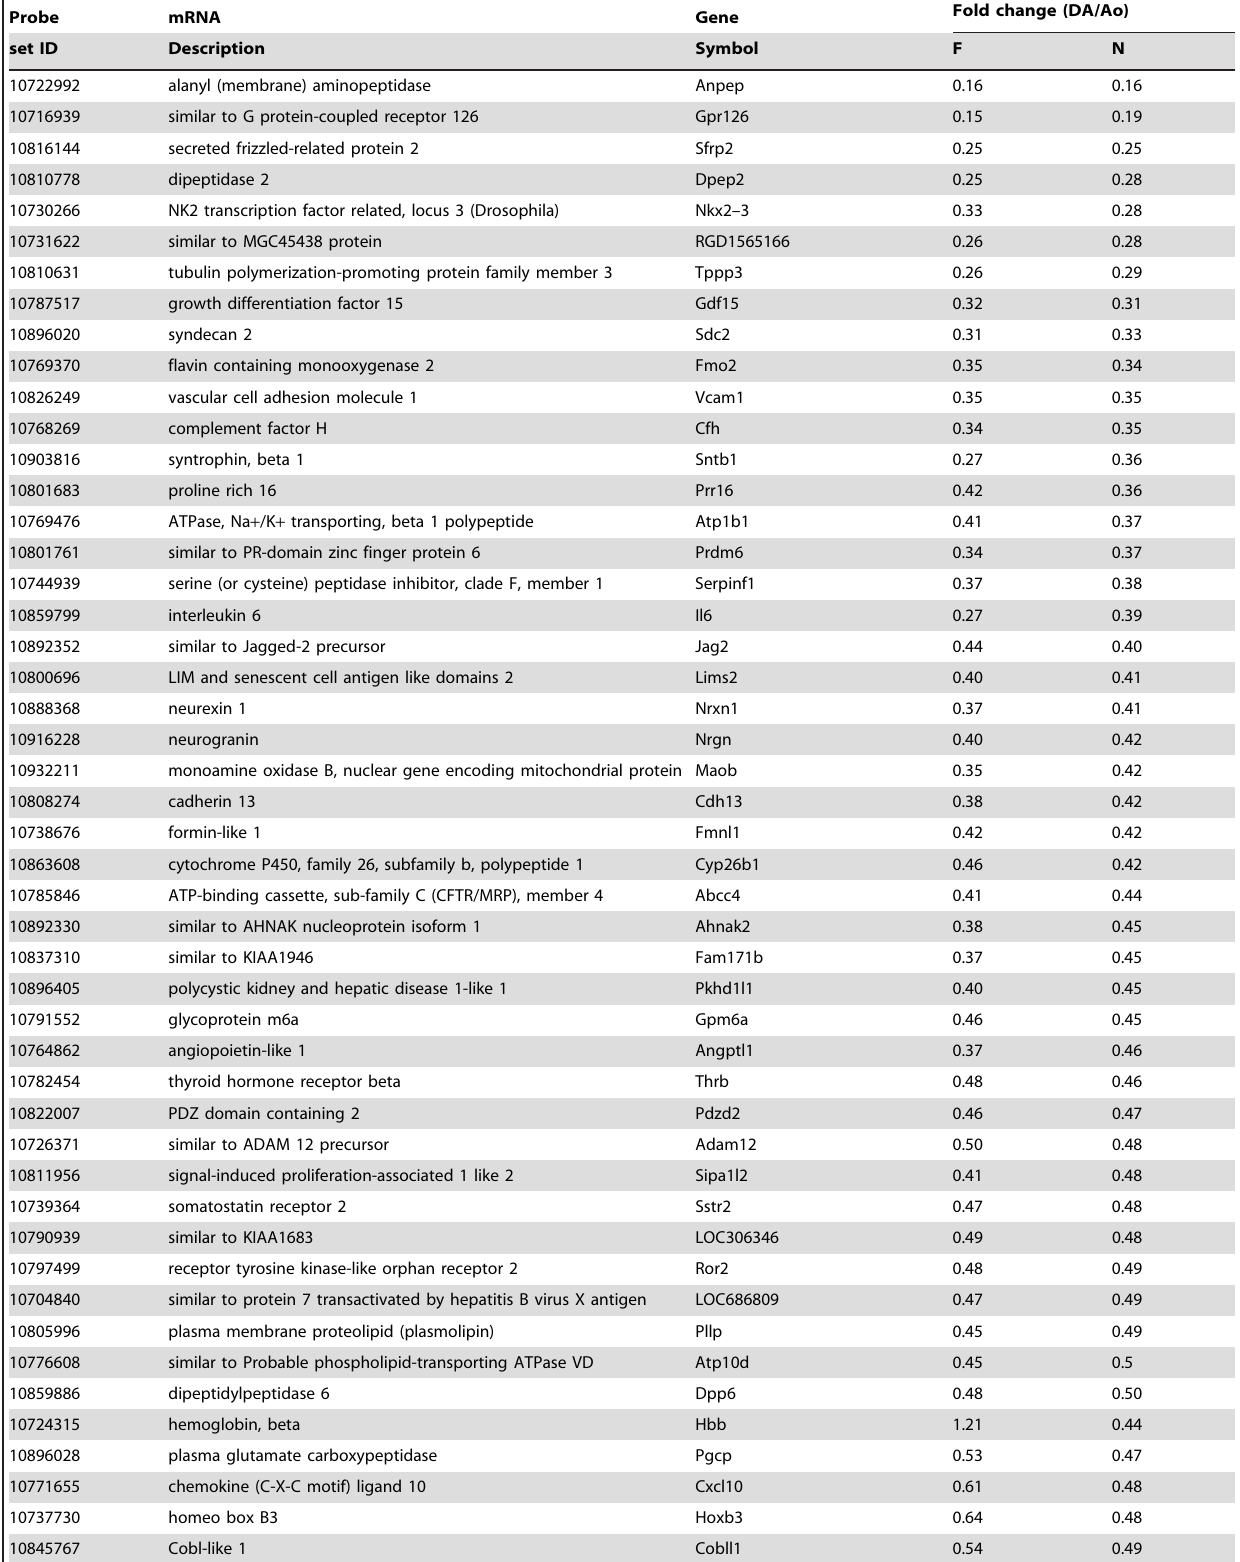
Table 3. Aorta endothelium-dominant